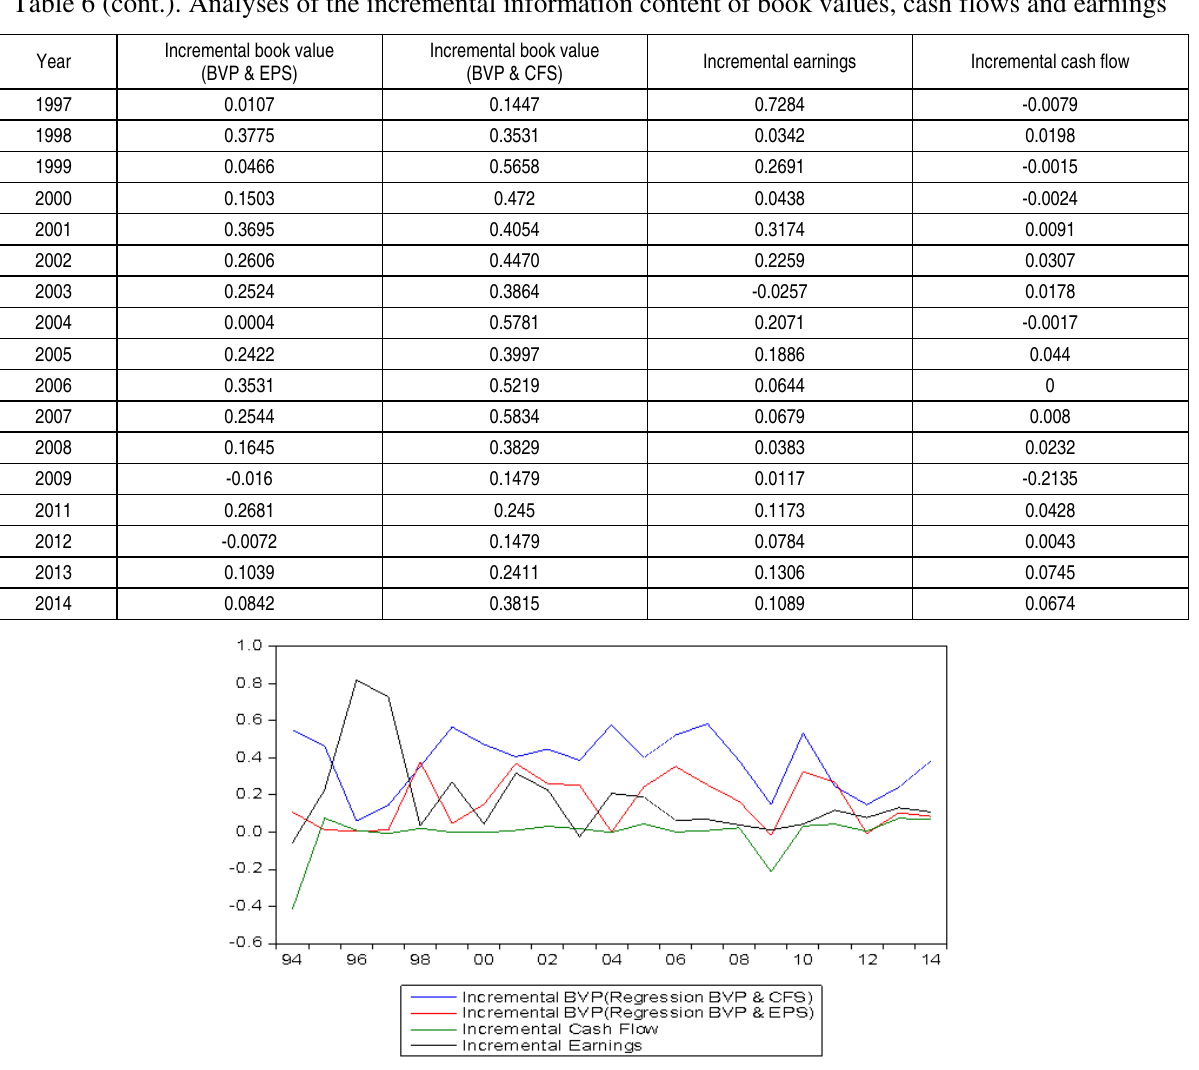
Fig. 3. Graphical view of the incremental information content of book value, cash flow and